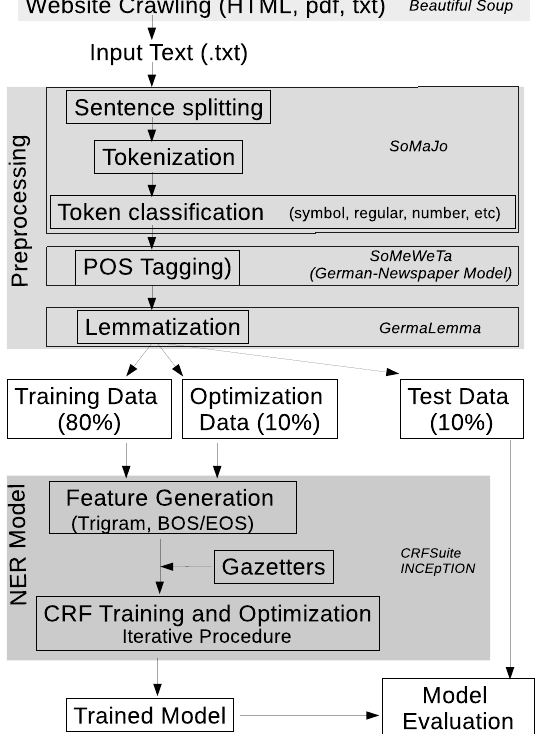
Figure 1. Preprocessing and NER modelling of the text dataset with indication of the tools used in each experimental